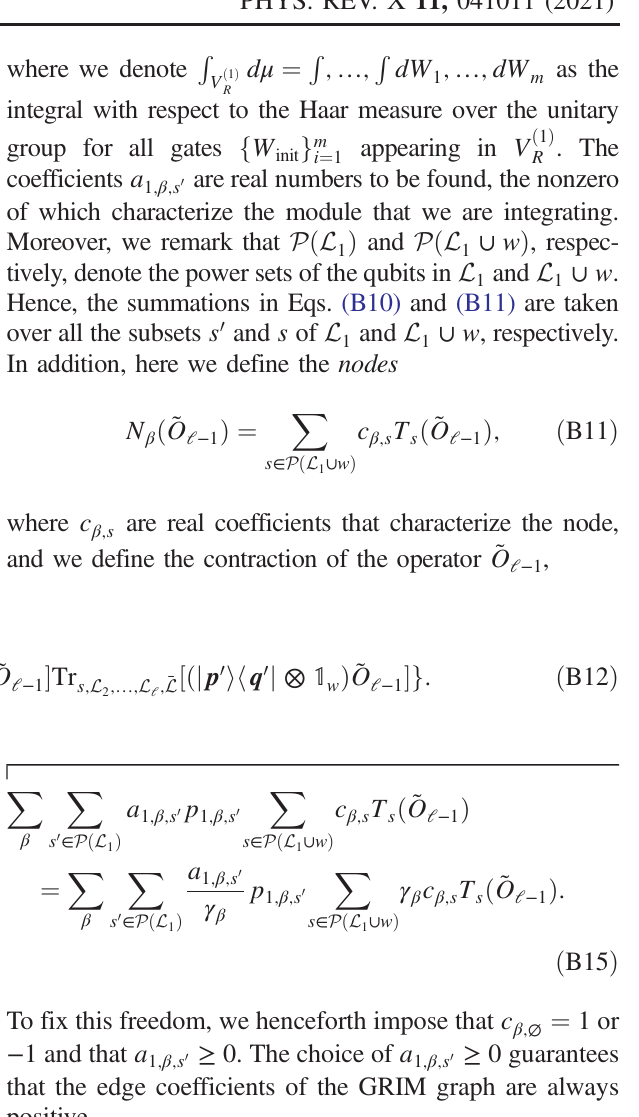
; β ;s . The node N α is F a α p α ; β ;s ¼ ; β ;s ; β ;s